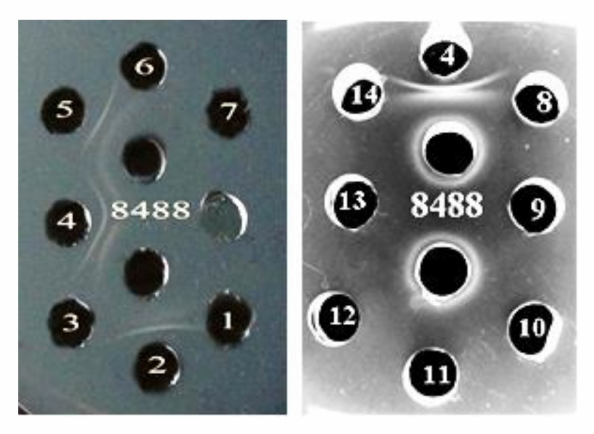
Figure 6. The reaction of Ouchterlony double immunodi ff usion in agar with O-antiserum to P. agglomerans 8488 (two central holes) and LPS from P. agglomerans 7960a (1), 7969 (2), 8456 (3), 8488 (4), 8490 (5), 8606 (6), 8674 (7), P1a (8), P324 (9), 7406 (10), 7604 (11), 9637 (12), 9649 (13), 9668(14). The white bars between the holes indicate the presence of an antigen-antibody